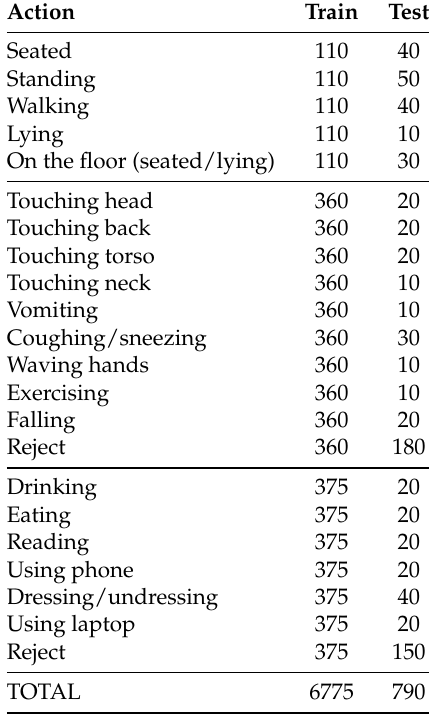
Table 5. ALMOND dataset training and test set division, with classes